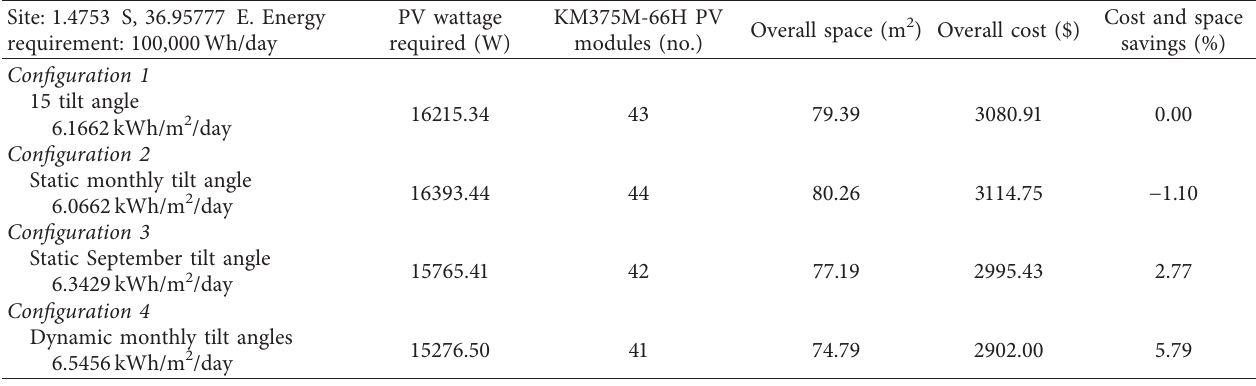
Table 6: Space and cost